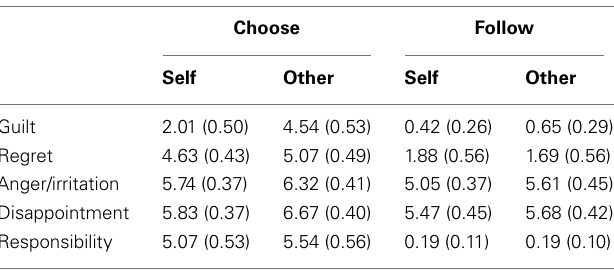
Table 1 | Subjective